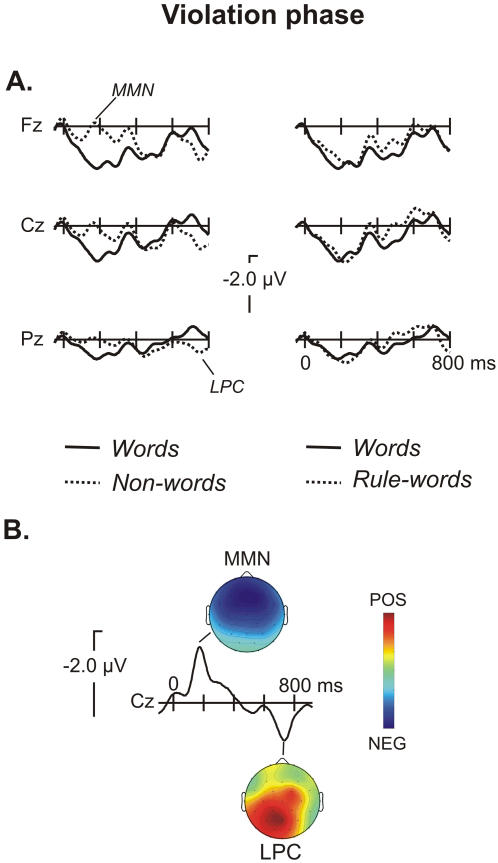
Illustration of the ERP results for the violation phase.A. Left panel: ERP averages from the onset of the presentation of words and new words that violated the previously acquired rule (non-words). An early Mismatch Negativity (MMN) appears, which indicates automatic detection of the rule violation. This negativity is followed by a late positive component (LPC) that could be assimilated into a P600 syntactic component. Right panel: ERP averages from the onset of the presentation of words and new words that violated the previously acquired rule (non-words). B. The difference waveform (subtracting non-words from words) has an MMN effect peaking around 190 ms after the onset of the non-word presentation and a fronto-central distribution. The LPC shows a more left lateralised parieto-occipital distribution that peaks around 720 ms after onset.